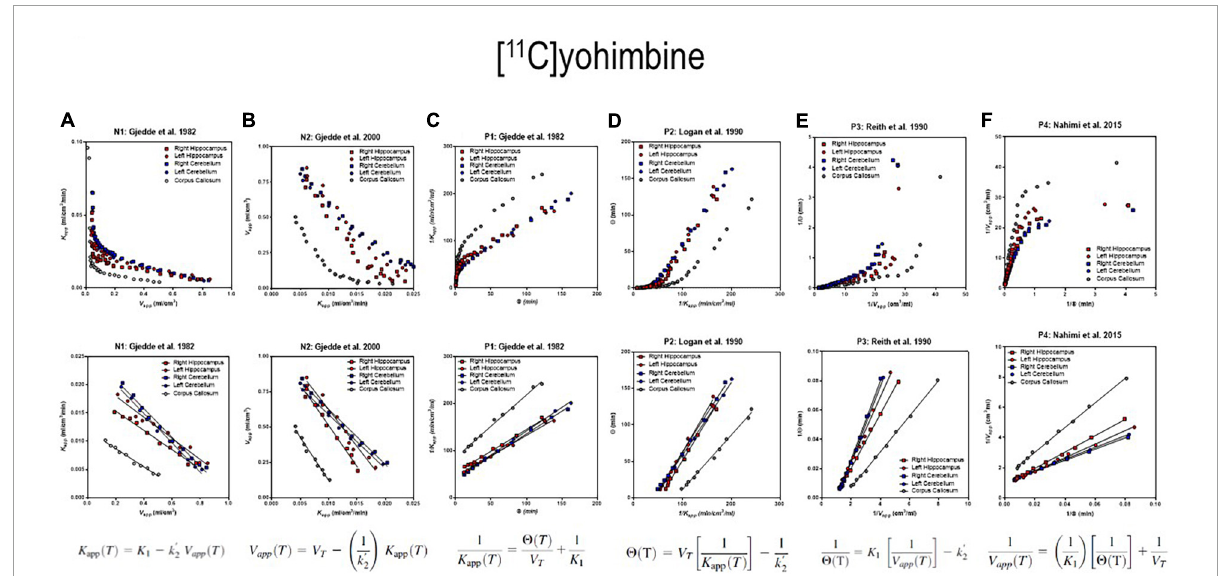
FIGURE4 Receptor binding relative to arterial input functions. (A , Top) (Graph N1) inversely related plot of y vs. x for entire duration of PET. (A , Bottom) (Graph N1) negative slope plot of linear relation. (B , Top) (Graph N2) inversely related plot of y vs. x for entire duration of PET. (B , Bottom) (Graph N2) negative slope plot of linear relation. (C , Top) (graph P1) positively related plot of y vs. x for entire duration of PET. (C , Bottom) (graph P1) positive slope plot of linear relation. (D , Top) (Graph P2) positively related plot of y vs. x for entire duration of PET. (D , Bottom) (Graph P2) positive slope plot of linear relation. (E , Top) (Graph P3) positively related plot of y vs. x for entire duration of PET. (E , Bottom) (graph P3) positive slope plot of linear relation. (F , Top) (Graph P4) positively related plot of y vs. x for entire duration of PET. (F , Bottom) (Graph P4) positive slope plot of linear relation. Adapted from Nahimi et al.